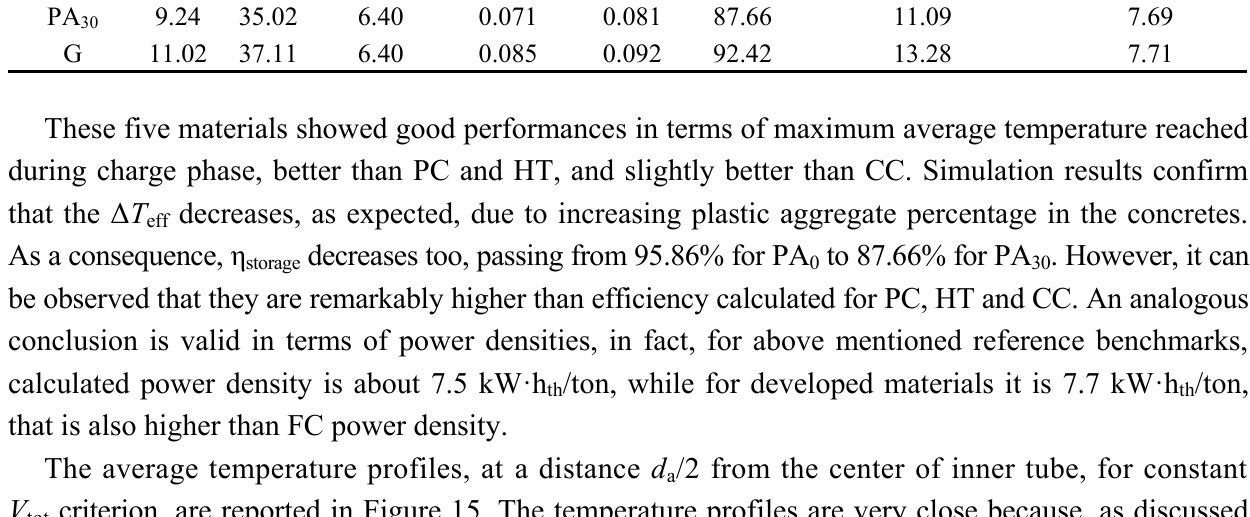
Table 7. Analysis results at constant V